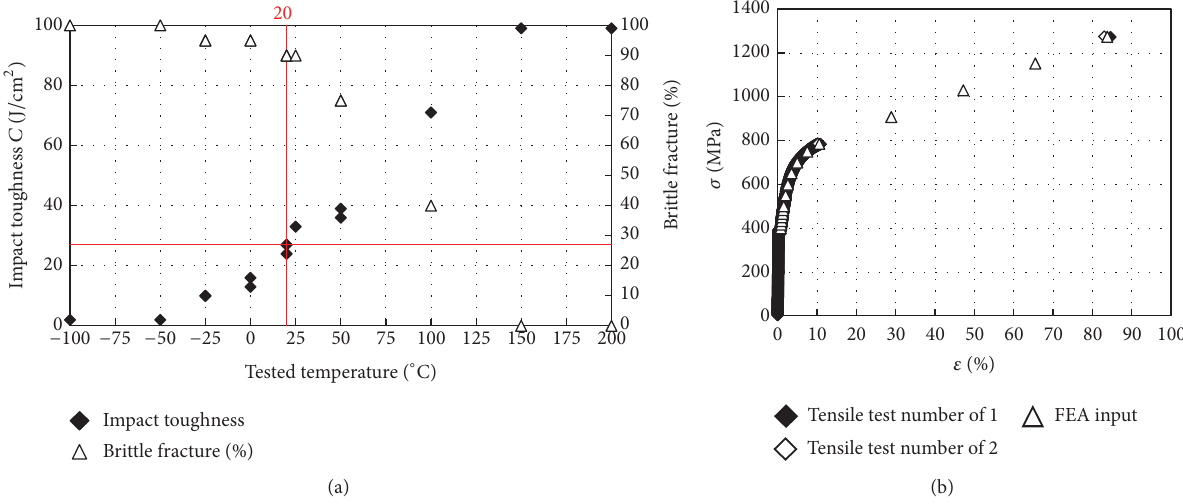
Figure 3: Charpy impact test results and true stress-true strain curves of JIS S55C steel (20 ∘